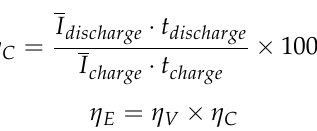
( b ) Figure 4. Ba tt ery voltages with di ff erent positive electrolyte fl ow rates at current densities of ( a ) 20 mA cm (cid:2879)(cid:2870) and ( b ) 40 mA cm (cid:2879)(cid:2870) .